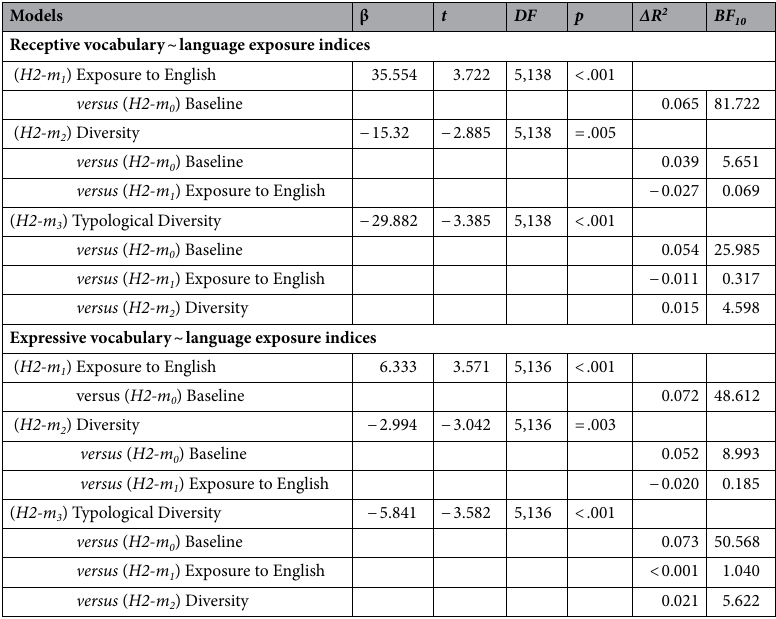
Table 2. Multiple regression model parameters for the receptive and expressive vocabulary scores, as predicted by the three language exposure indices (Exposure to English, Diversity and Typological Diversity), and model comparison results (additional variance explained and BF 10 values).